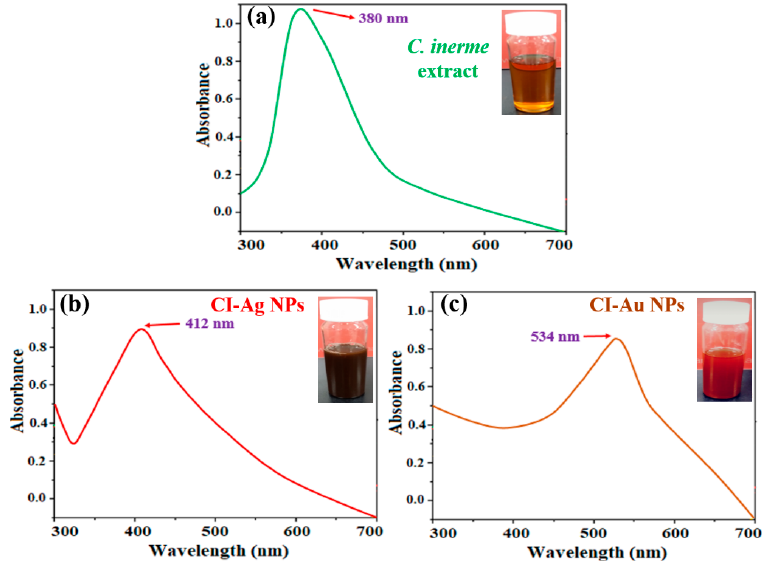
Figure 4. Absorption spectra of ( a ) extract of C. inerme leaves, ( b ) CI-Au NPs and ( c ) CI-Ag NPs.